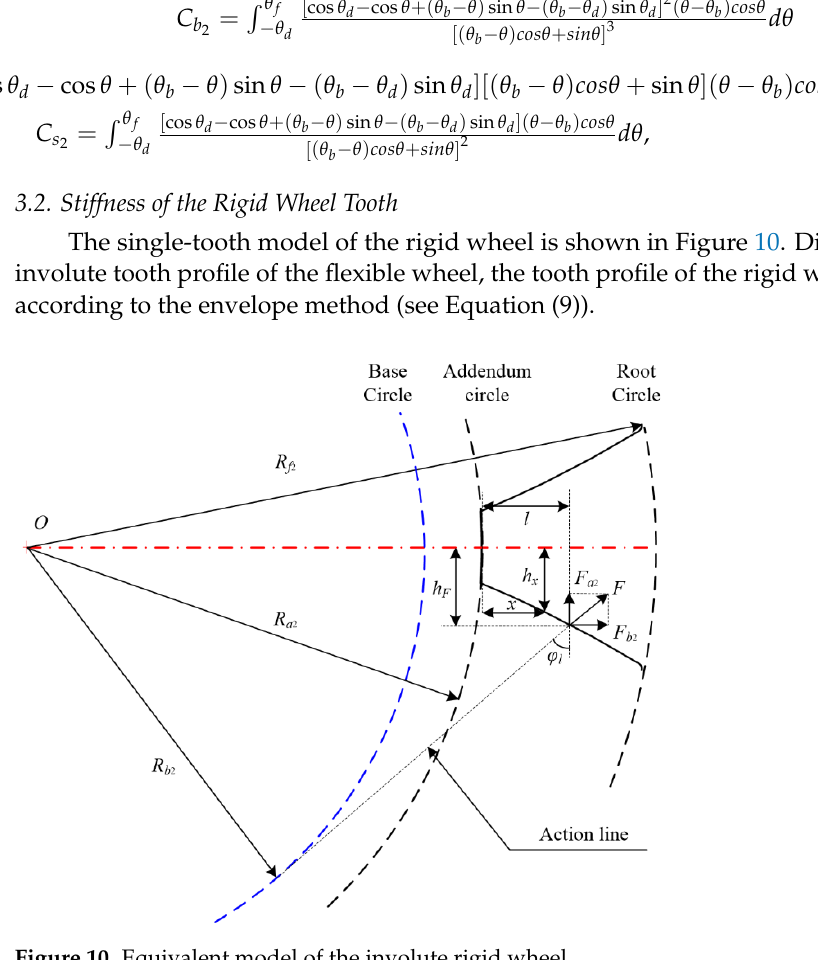
Figure 10. Equivalent model of the involute rigid wheel.